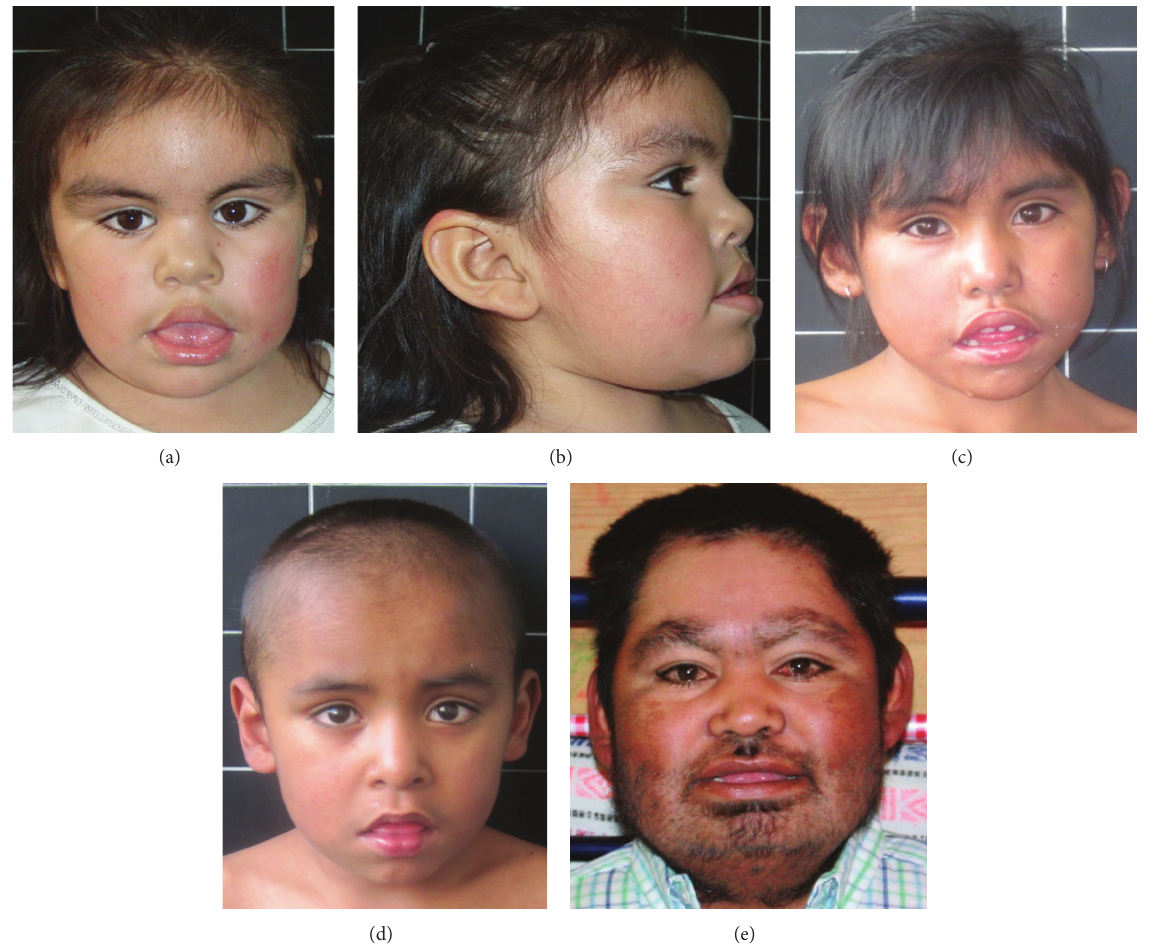
Figure 2: Phenotype of the four family members with the dup(3q) syndrome. (a) Frontal and (b) semilateral views of Case 1 (proband). (c) Case 2. (d) Case 3. (e) Case